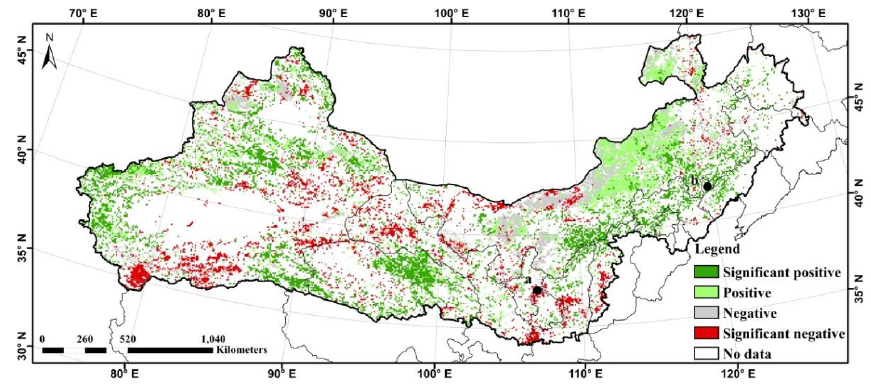
Figure 7. Figure 7. Spatial pattern of the significant changes in vegetation production induced by human activities. The regeneration regions were mainly in the northern portion of Xinjiang Province, the northeastern portion of the Qinghai Province, and along a northeast-to-southwest bank along the